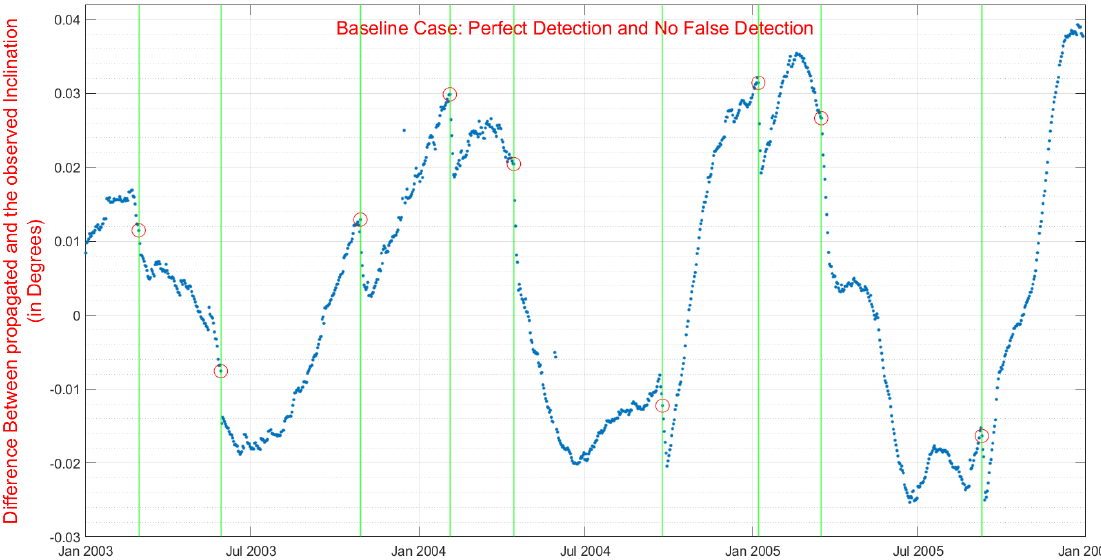
Figure 3. Baseline case: Perfect detection and no false detection. Vertical green lines represent the maneuvers and the red circles represent potential maneuvers detected by this